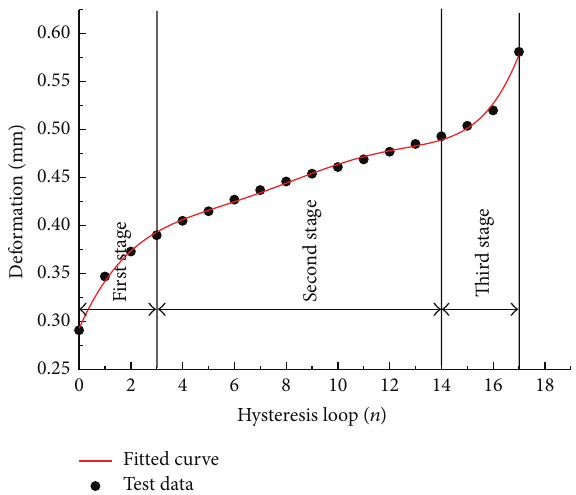
Figure 6: Relationship between hysteresis loop and